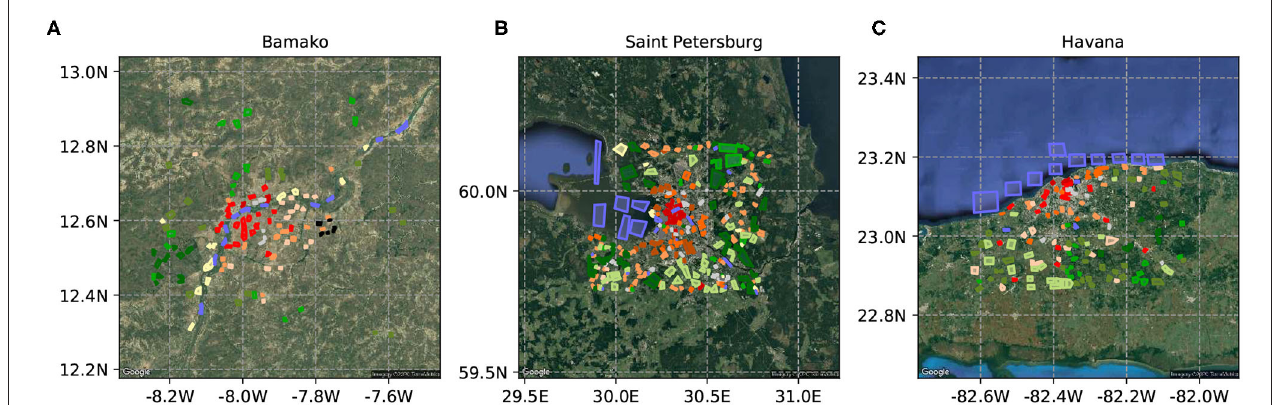
FIGURE 4 | Training areas for (A) Bamako, (B) Saint Petersburg, and (C) Havana. Color scheme as in Figure 1 .